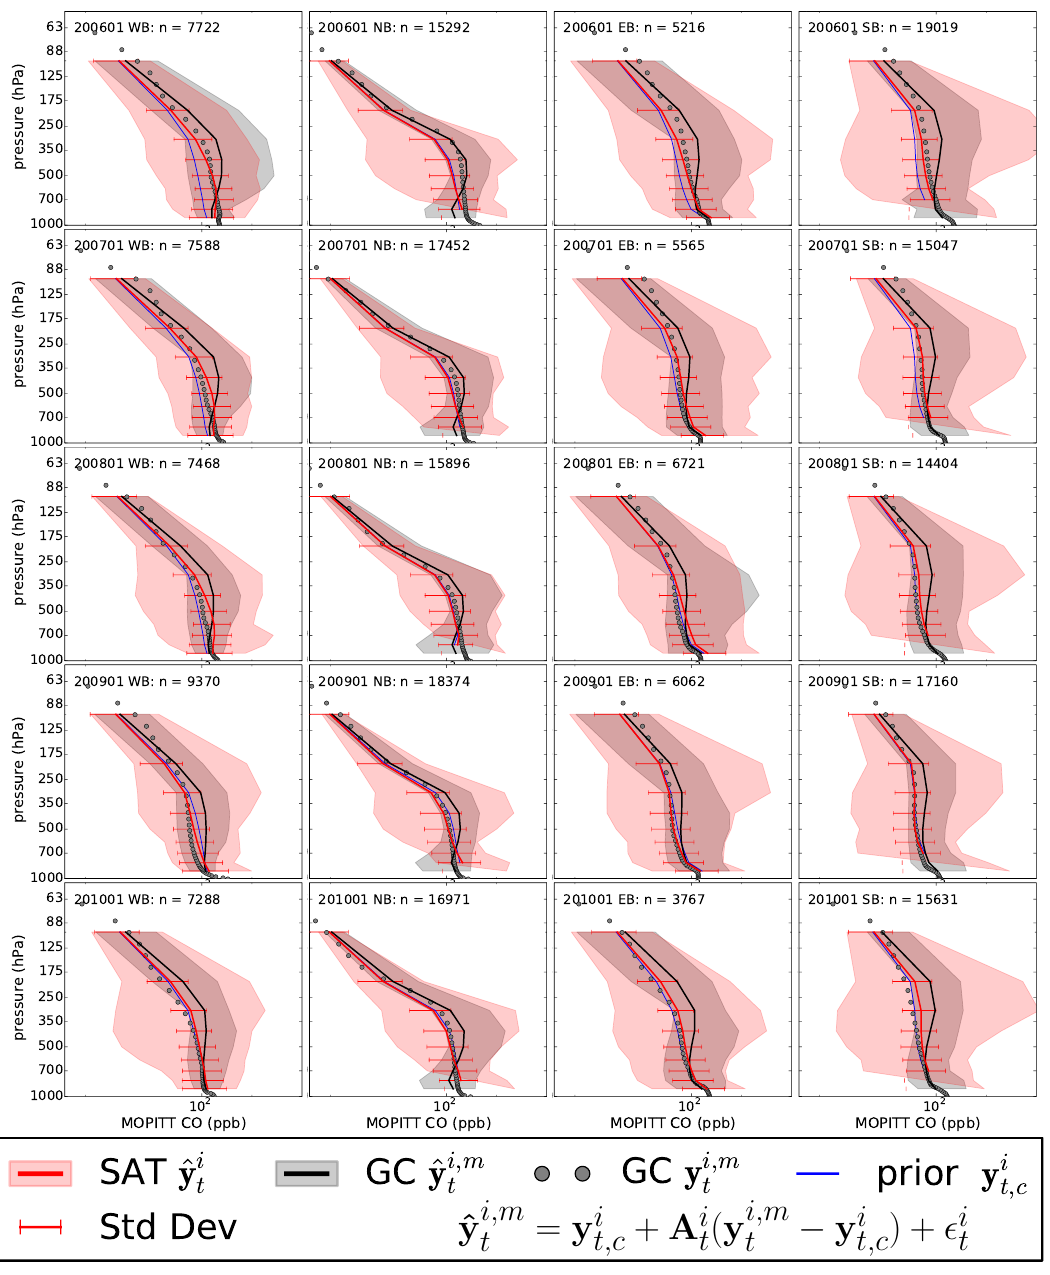
Fig. A5. Same as Fig. A1, but for MOPITT.